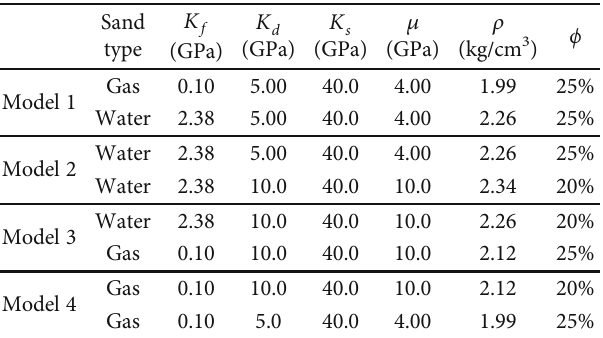
Figure 1: The relationships of the coe ffi cients of the four terms in equation (15) with the incident angle ranging from 0 ° to 60 ° for three dry rock velocity ratios of γ 2 dry = 1 : 333 (red solid line), γ 2 dry = 2 : 0 (blue dotted line), and γ 2 dry = 2 : 333 (green dashed line). The coe ffi cients of the term of (a) Δ K f / K f , (b) Δ Y / Y , (c) Δμ m / μ m , and (d) Δρ / ρ . Table 2: Four sandstone models used for the forward